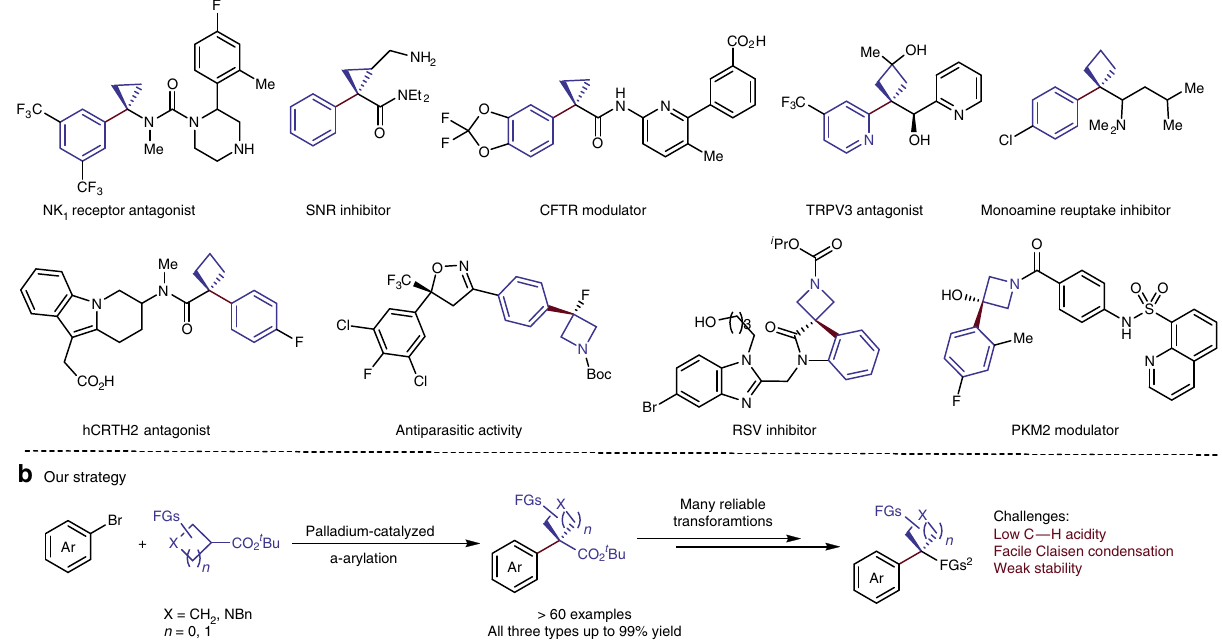
Fig. 1 Representative biologically active molecules containing small rings and our strategy for their synthesis. a Selected biologically active molecules containing aryl-substituted small rings. b Our strategy for the introduction of small rings to aromatic compounds. FG: functional